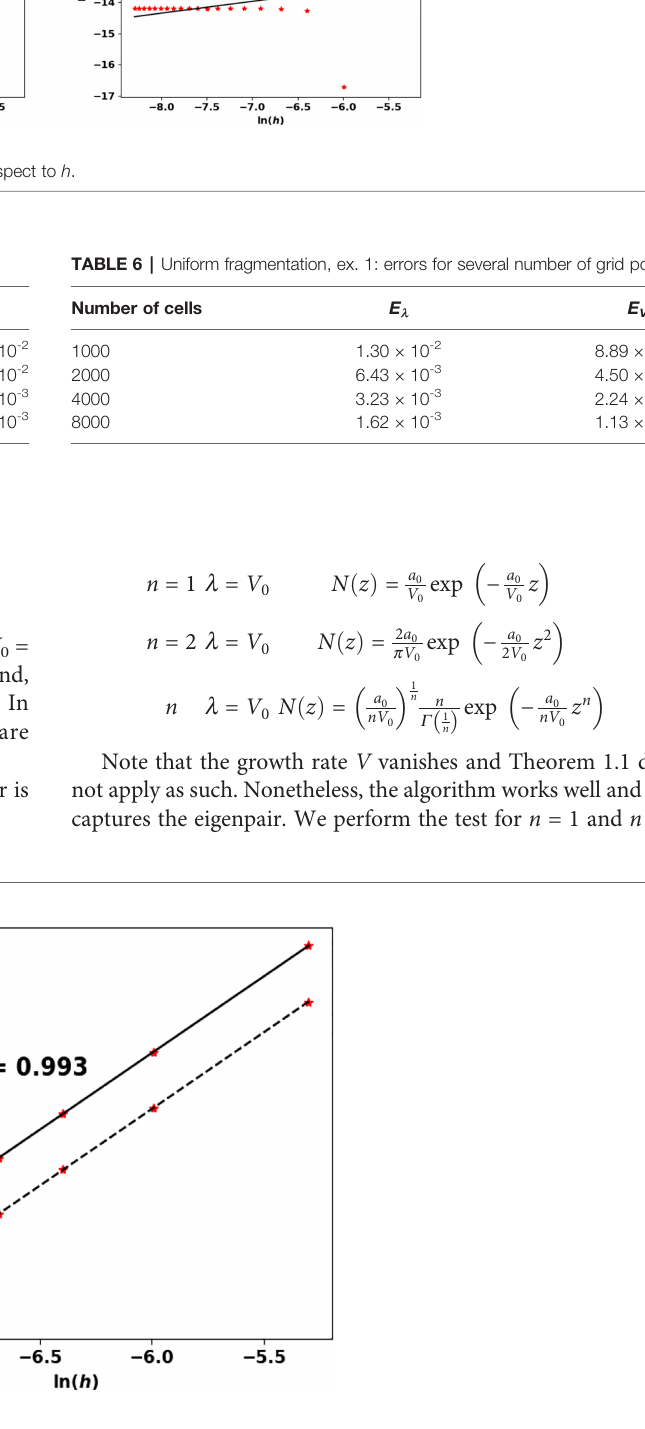
FIGURE 11 | Uniform fragmentation, ex. 1: rate of convergence to the exact eigenpair with respect to h